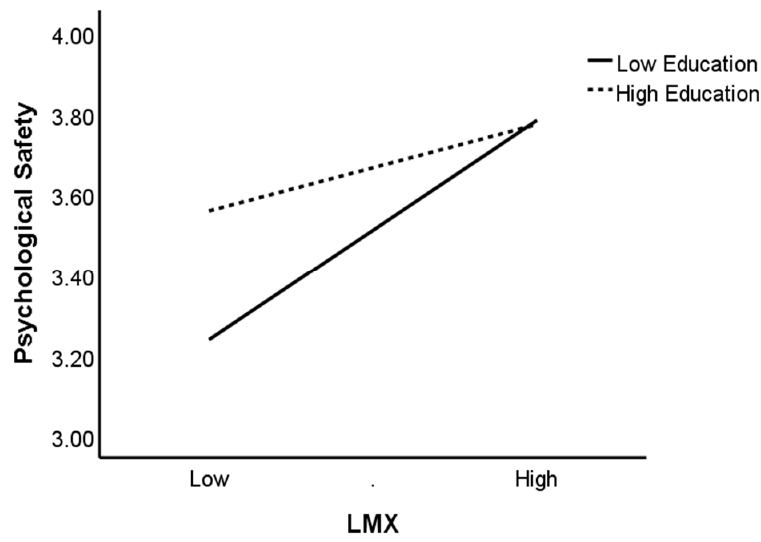
Figure 2. The moderating effect of education level on the relationship between LMX and psychological safety.